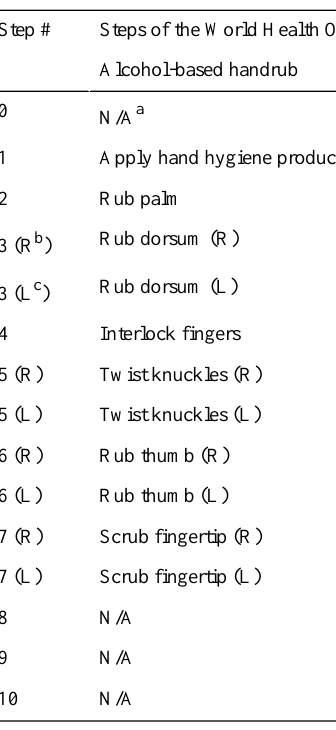
Table 1. Steps of the World Health Organization hand hygiene procedures.